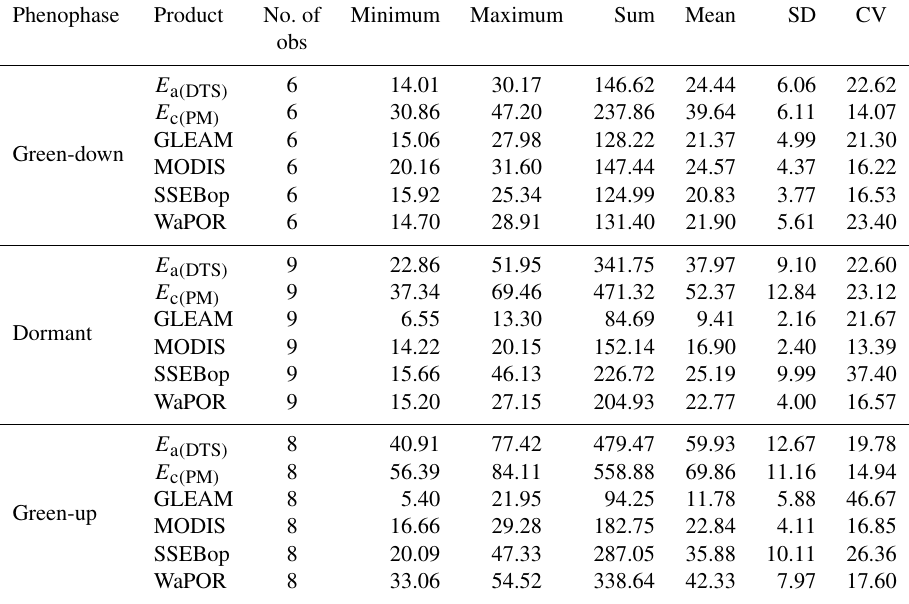
Table A3. Descriptive statistics of evaporation products at phenophase